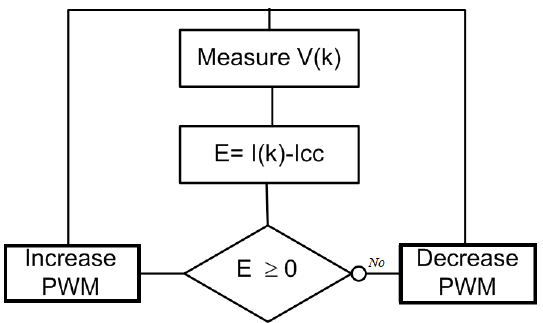
Figure 12. Flowchart of the ANN FCC MPPT method algorithm.